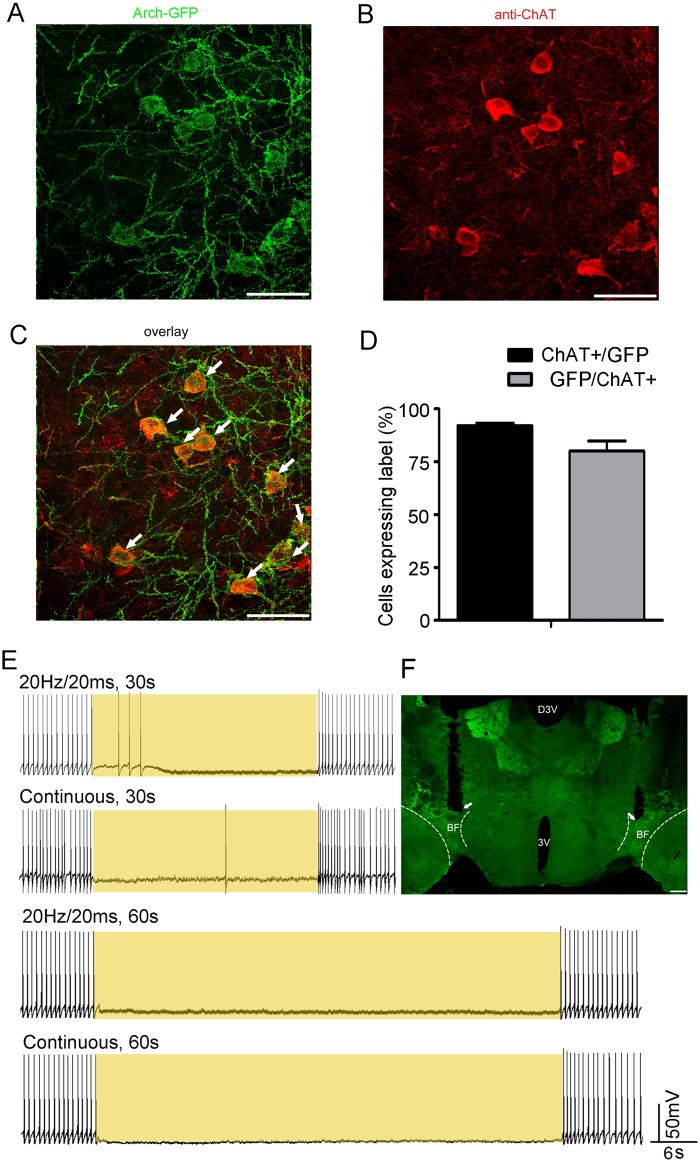
Specific and efficient expression of Arch-GFP in cholinergic BF neurons of ChAT-Arch mice.(A–C) Representative photomicrographs of the BF depicting Arch-GFP expression (A, green), ChAT immunoreactivity (B, red), and overlaid images (C) from a ChAT-Arch mouse. Scale bars, 50 μm. (D) Statistics of the total co-expression of GFP and ChAT immunofluorescence from ChAT-Arch mice (n = 5) in 30-μm sections from the rostral-to-caudal ends of the BF (anteroposterior, -0.4 to -0.8). Cell counts are represented as mean ± s.e.m. (E) Yellow light inhibits the activity of Arch-expressing cholinergic BF neurons. Action potentials recorded under current-clamp from a neuron expressing Arch-GFP in a BF slice in response to 20 Hz yellow light pulse trains (20 ms per pulse) or continuous yellow light for 30 s (upper trace). Action potentials recorded under current-clamp from a neuron expressing Arch-GFP in a BF slice in response to 20 Hz yellow light pulse trains (20 ms per pulse) or continuous yellow light for 60 s (lower trace). (F) Representative photomicrographs of Arch-GFP expression in BF from a ChAT-Arch mouse. White arrow indicated a fiberoptic lesion track. 3V, 3rd ventricle; D3V, dorsal 3rd ventricle. Scale bars, 200 μm.